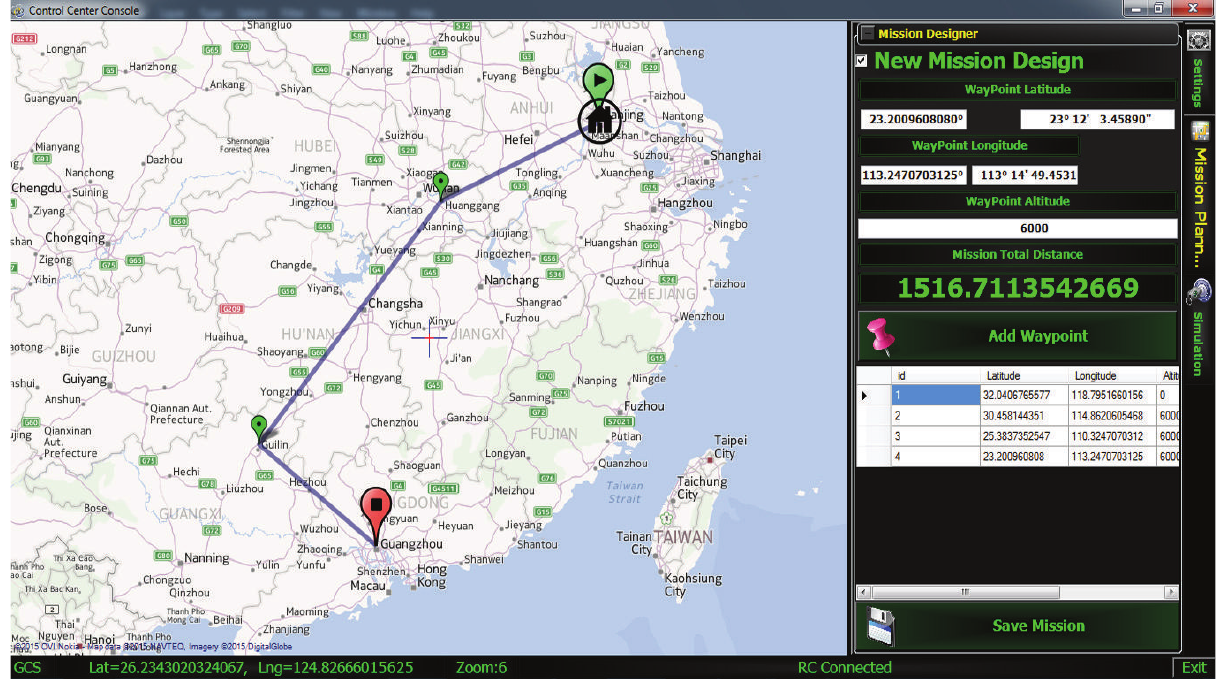
Figure 4: Mission designer interface snapshot.